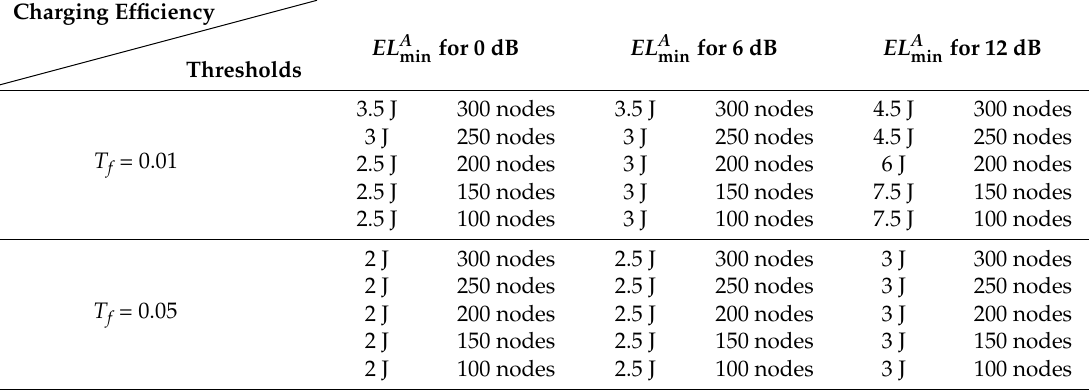
Table 1. Simulation